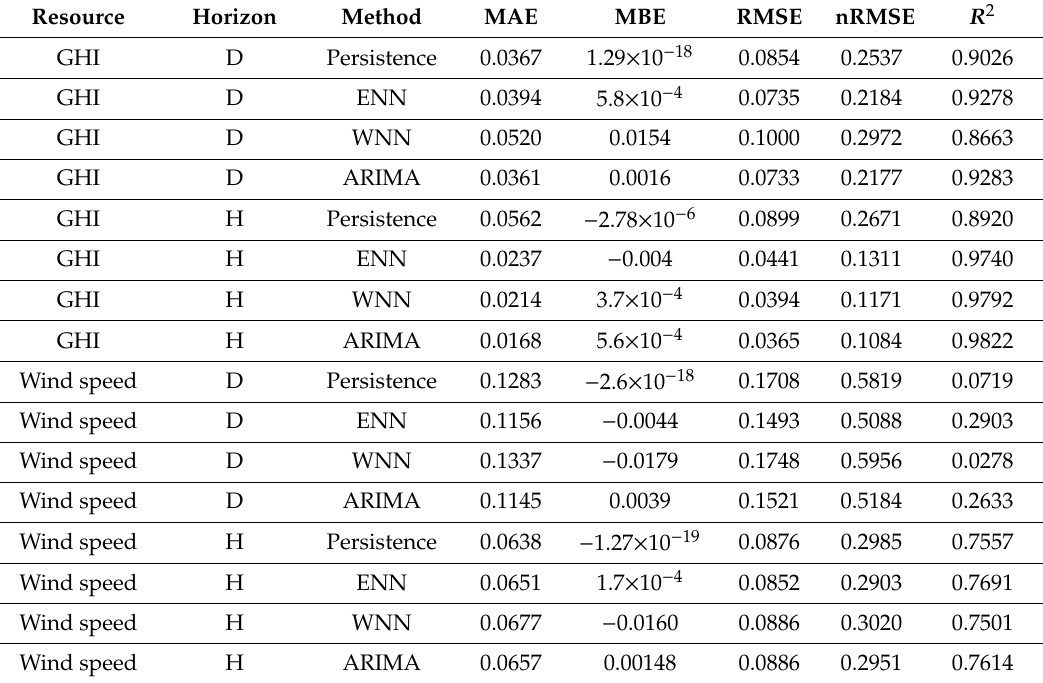
Table 4. GHI and Wind Speed Forecasting